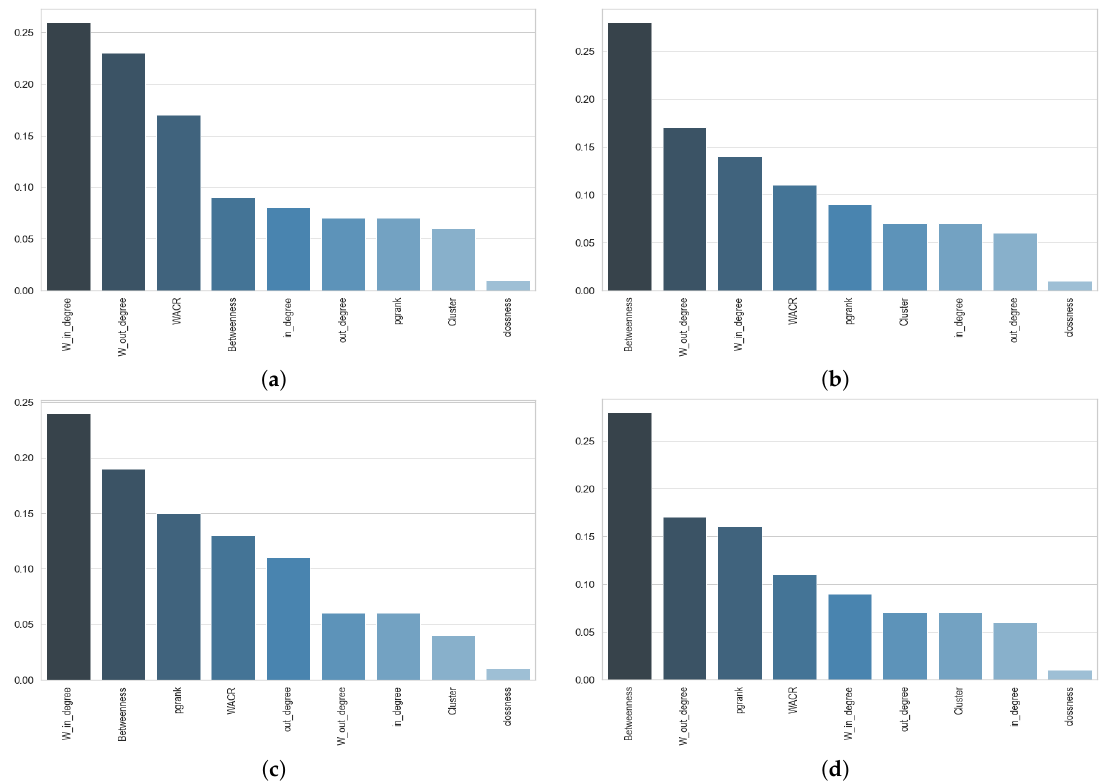
Figure 7. Importance of features for ( a ) Isfahan, ( b ) Enschede, ( c ) Tehran, and ( d )